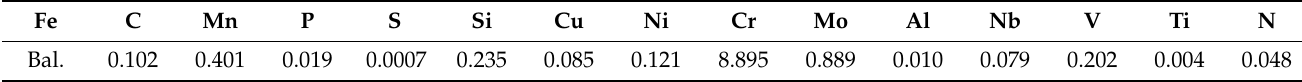
Table 1. Chemical composition of T91 steel in wt. % (supplied by Industeel). Fe C Mn P S